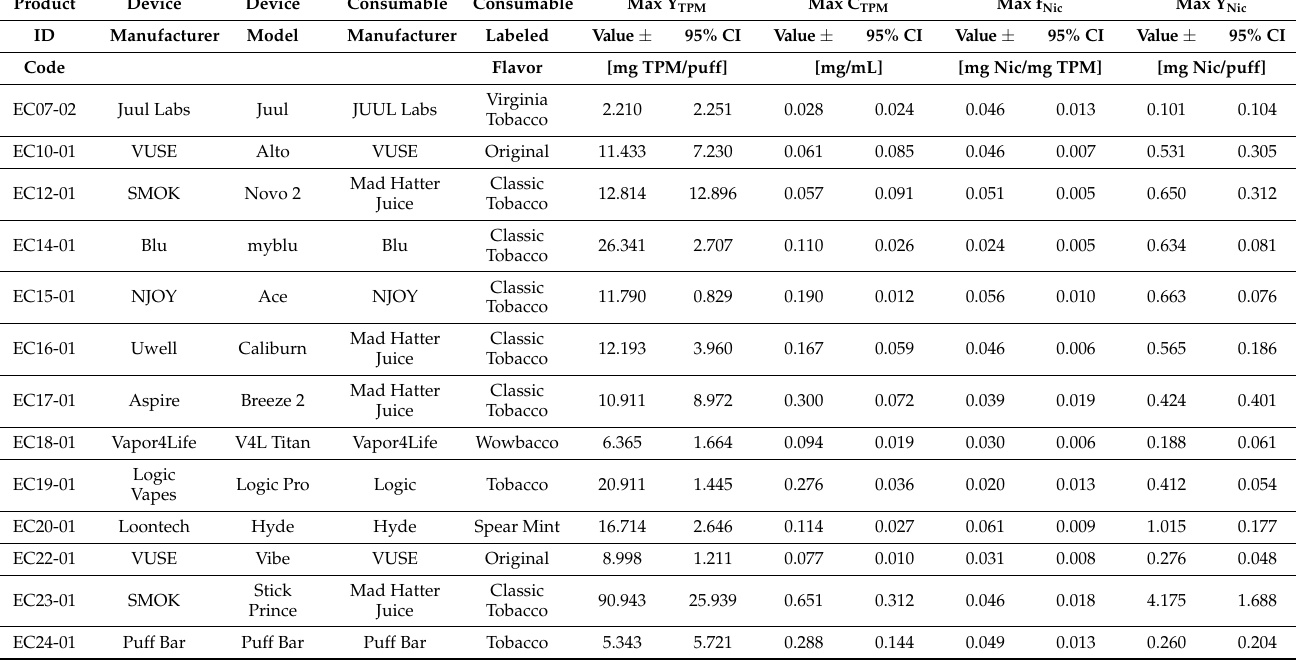
Table 3. Maximal emissions characteristics for 13 pen- and pod-style electronic nicotine delivery